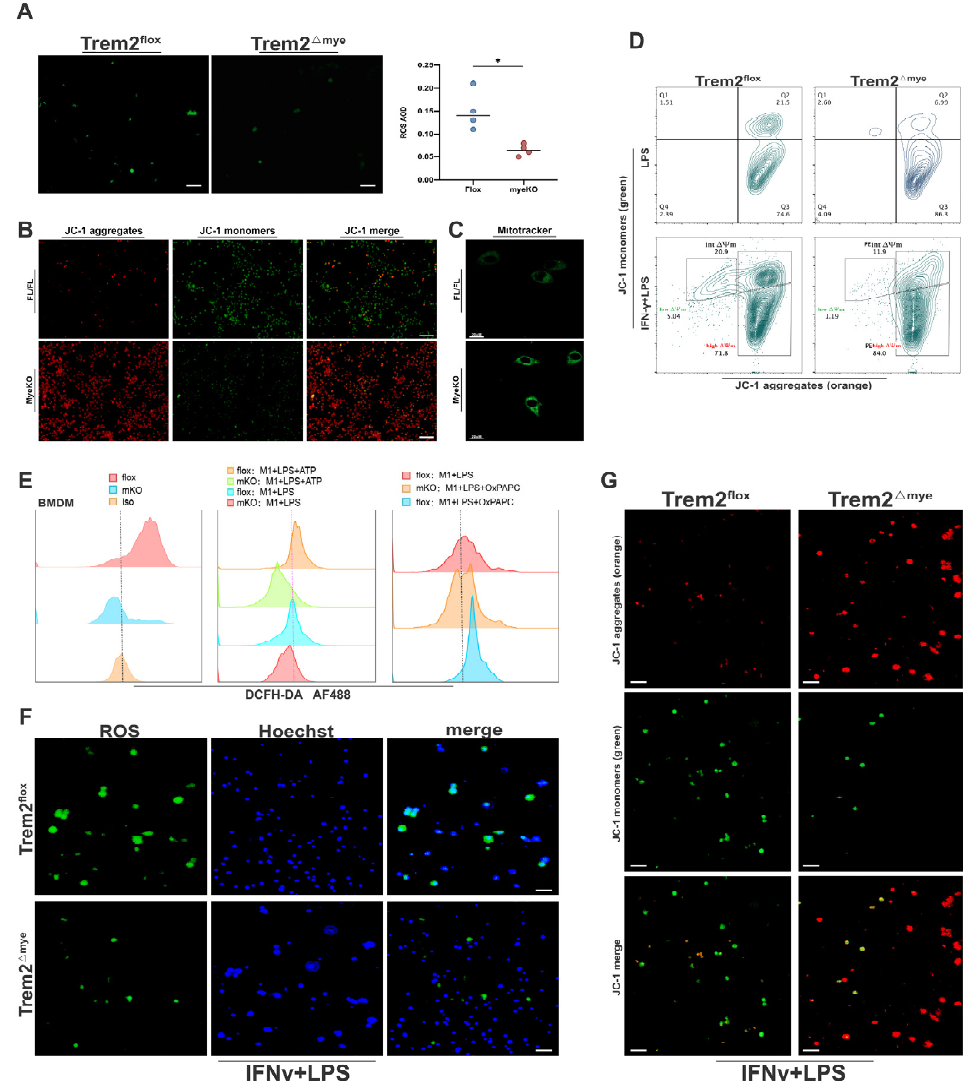
Figure 3. Trem2 deficiency suppresses mitochondrial damage, and ROS release in macrophages in response to oxidative stress ( A ) ROS production from liver NPC of Trem2 FL/FL or Trem2 mKO at IR6h was detected by immunofluorescence (* p < 0.05, scale bars = 100 μ m); ( B ) JC1 detects mitochondrial membrane potential (scale bars = 200 μ m) and ( C ) Mitotracker detects mitochondrial function (scale bars = 20 μ m). ( D ) Mitochondrial membrane potential of BMDMs by 1 μ g/mL LPS stimulated for 6 h or 200 ng/mL LPS + 10 ng/mL IFN γ for 24 h and then measured by JC1 enhanced detection kit; ( E ) ROS release was measured by flow cytometry DCFH-DA; ( F ) Mitochondrial membrane potential, scale bars = 200 μ m and ( G ) ROS changes of BMDMs with or without Trem2 in response to LPS or IFN γ + LPS stimulation was detected by immunofluorescence, scale bars = 200 μ m.